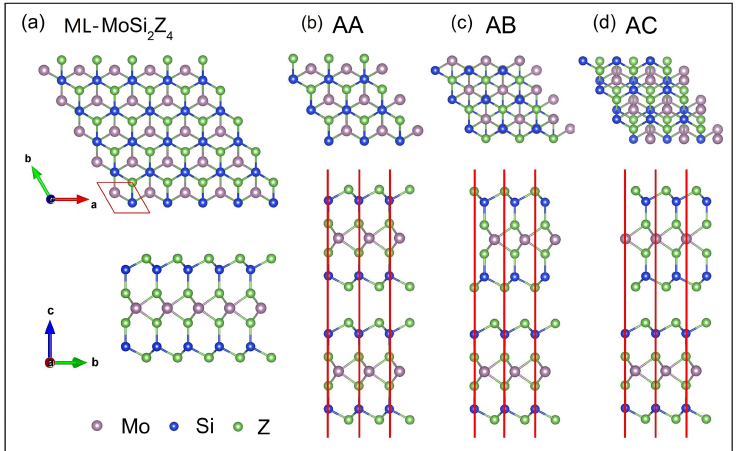
Figure 1. ( a ) Schematic structure of monolayer MoSi 2 Z 4 (Z = P, As) from top view and side view. The parallelogram indicates its primitive cell. ( b ) AA, ( c ) AB, ( d ) AC stacking patterns of bilayer MoSi 2 Z 4